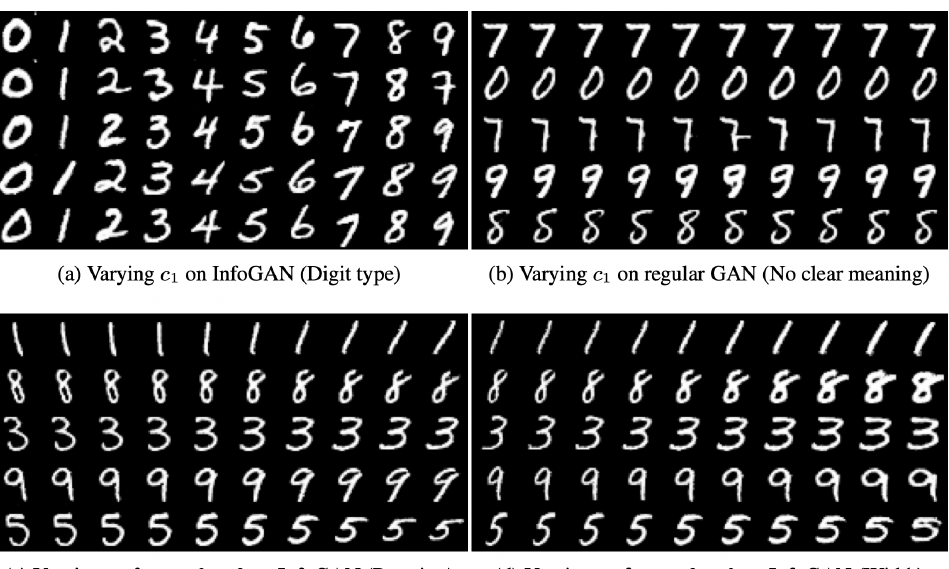
Figure 11. The semantic meaning InfoGAN adds to the latent variables in the MNIST dataset. In ( a ), varying the latent variable c 1 leads to a digit change (from 0 to 9), while in ( b ), a regular GAN does not add meaning to its latent variables. In ( c ), the variation of c 2 leads to the rotation of digits. Finally, in ( d ), variation c 3 controls the width of the digits. Image taken from [31].